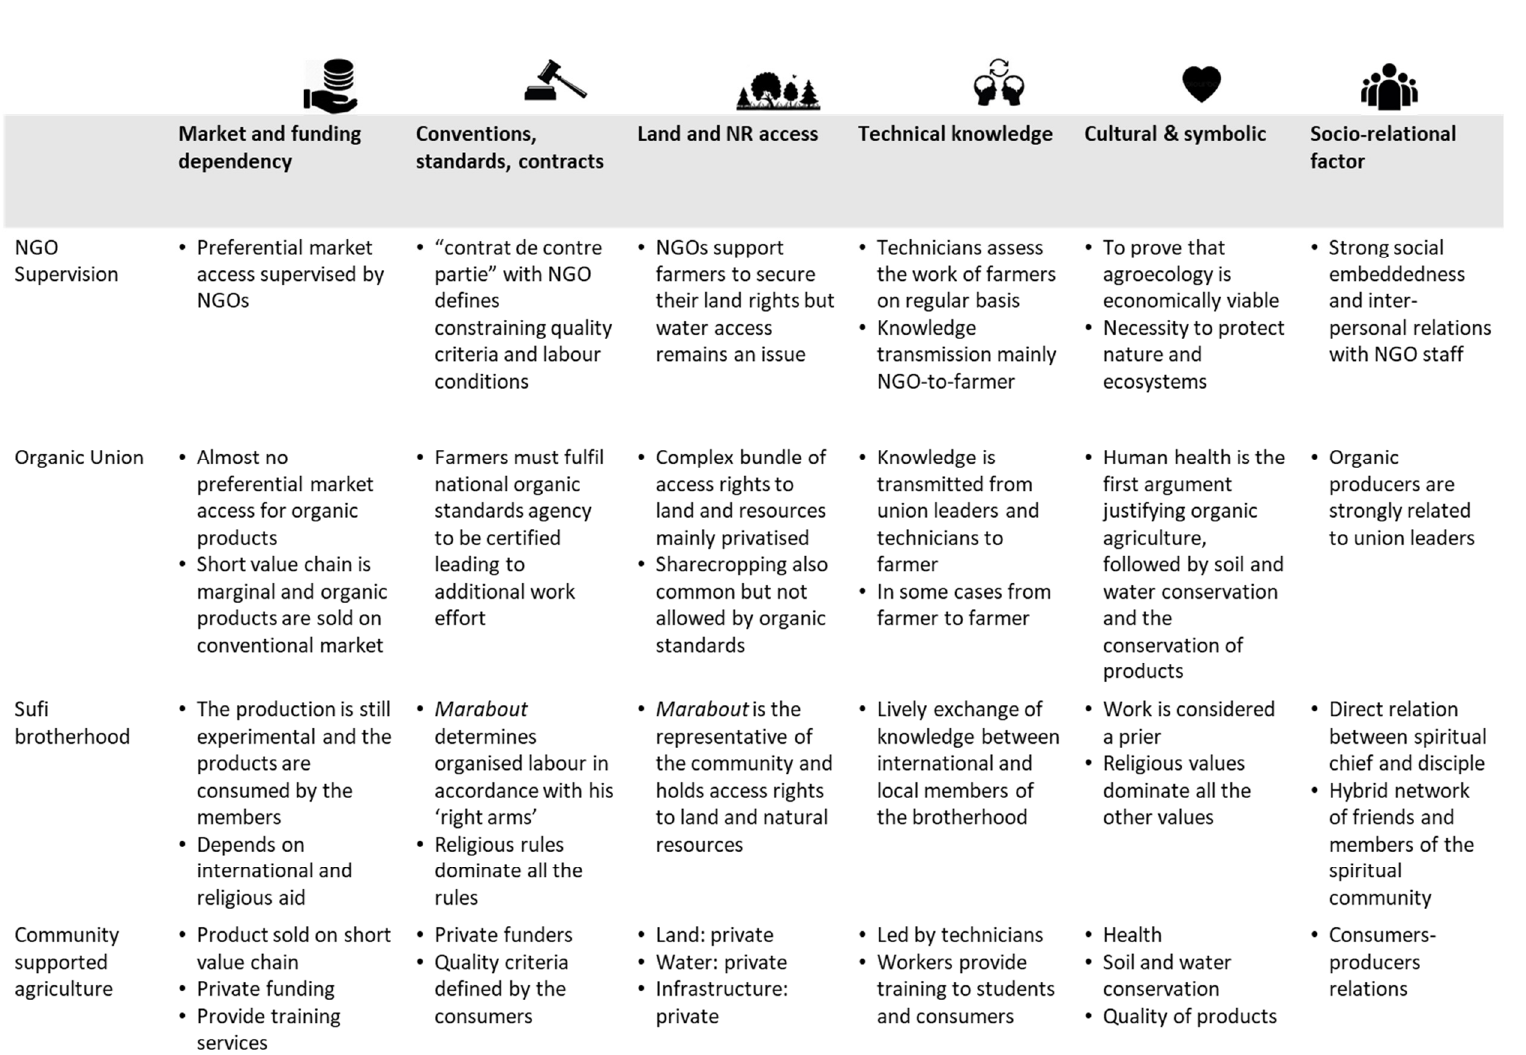
Figure 3. Channels of labour control in Senegalese agroecological initiatives. Source: Elaboration from authors’ field-work interviews.